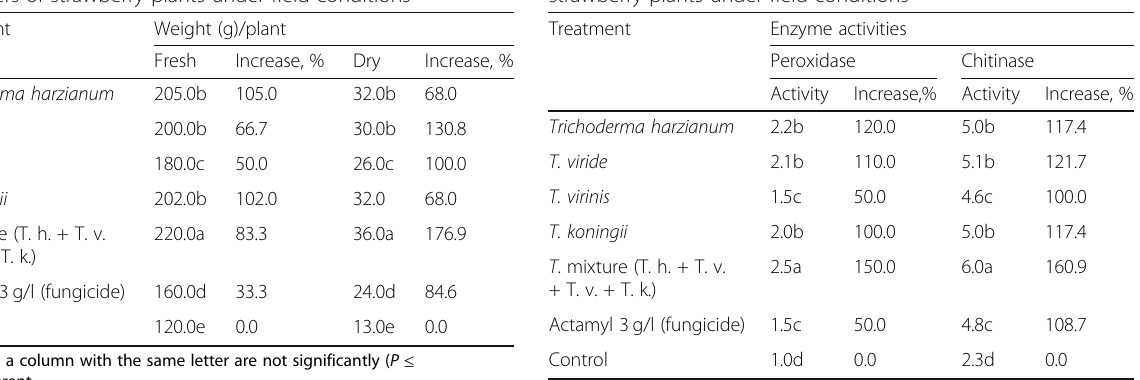
Table 5 Effect of four Trichoderma spp. on enzyme activities